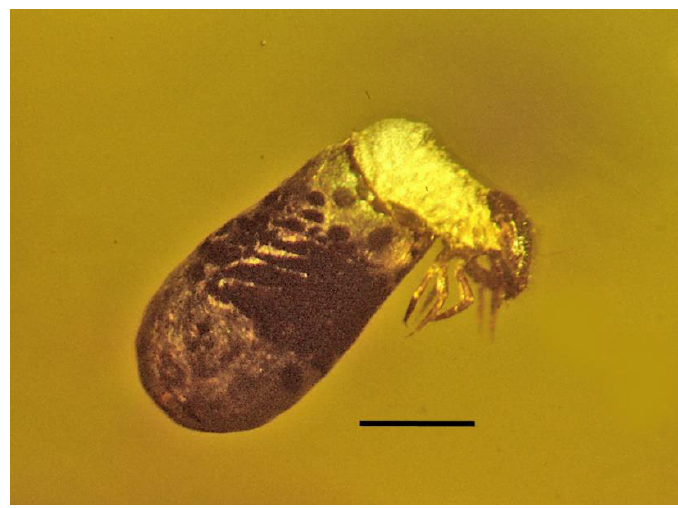
Figure 28. Case-bearing chrysomelid beetle larva (Coleoptera: Chrysomelidae) in Dominican amber. Scale bar = 1.0 mm.